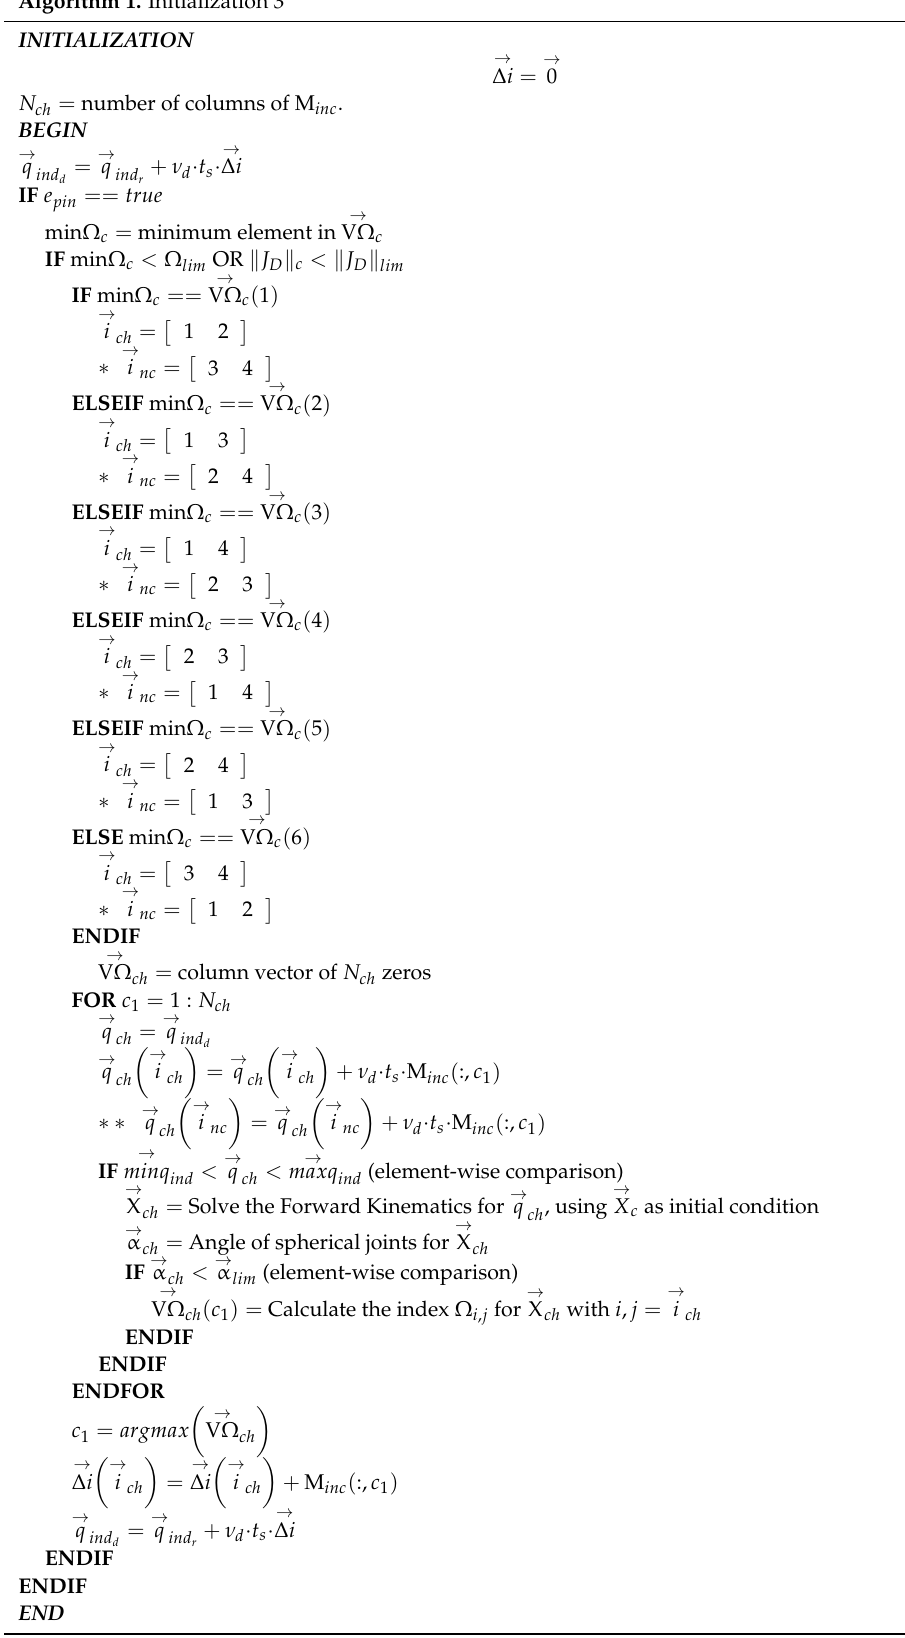
Algorithm 1. Initialization